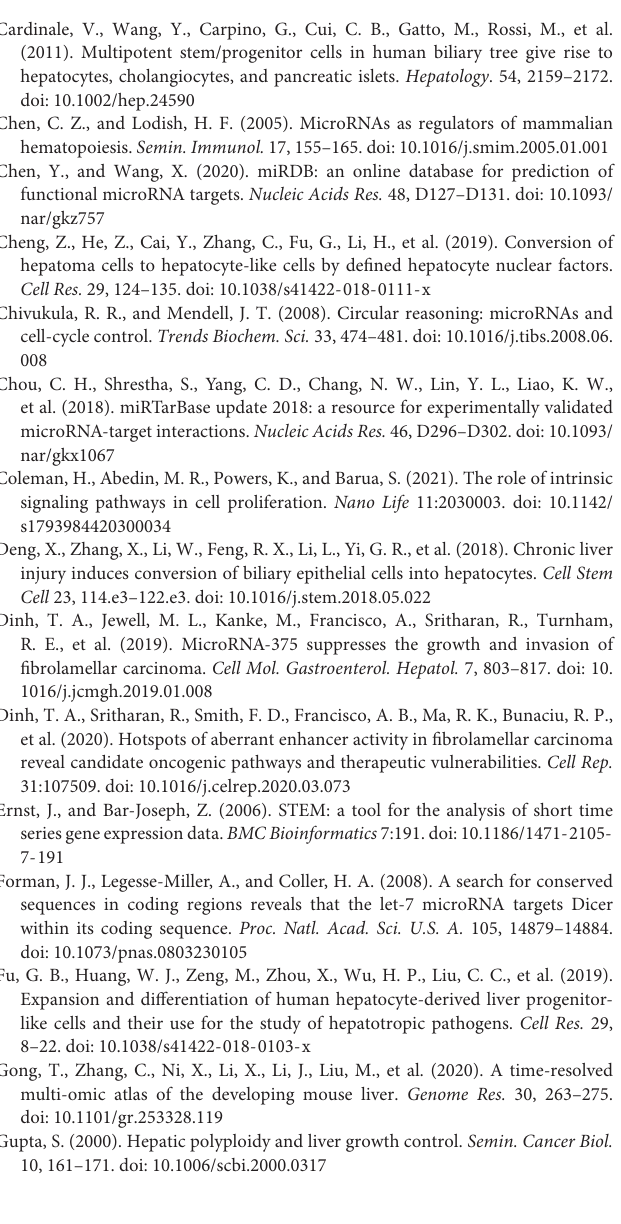
Supplementary Figure 1 | The specific regulated mechanism of KEGG_hsa_04550. The different color of each gene shows the potential number of their interacted miRNAs. Supplementary Figure 2 | Immunohistochemistry (IHC) of 13 genes in the HPA database. Supplementary Figure 3 | GSVA analysis of GSE73114 and GSE90047 bulk RNA-seq. (A) Heatmap of all GSVA-enriched miRNA terms